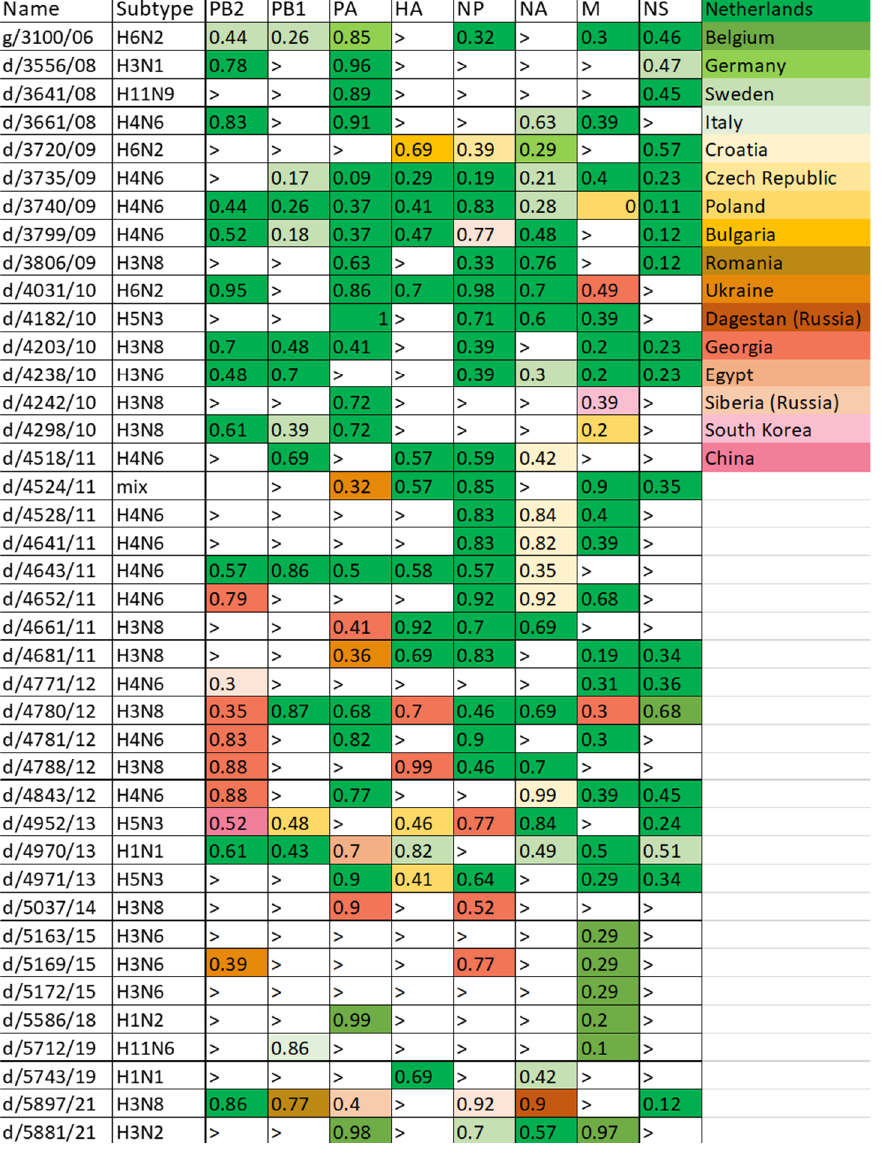
Figure 3. Regions of isolation of the most closely related virus for Moscow isolates. The color of the cells corresponds to the region of isolation of the most closely related variant relative to the Moscow isolate. The numbers in the cells reflect the % of nucleotide substitutions relative to the Moscow isolate. The > sign in the cells means that the difference exceeded 0.5% for the M and NS segments or 1% for the remaining segments.